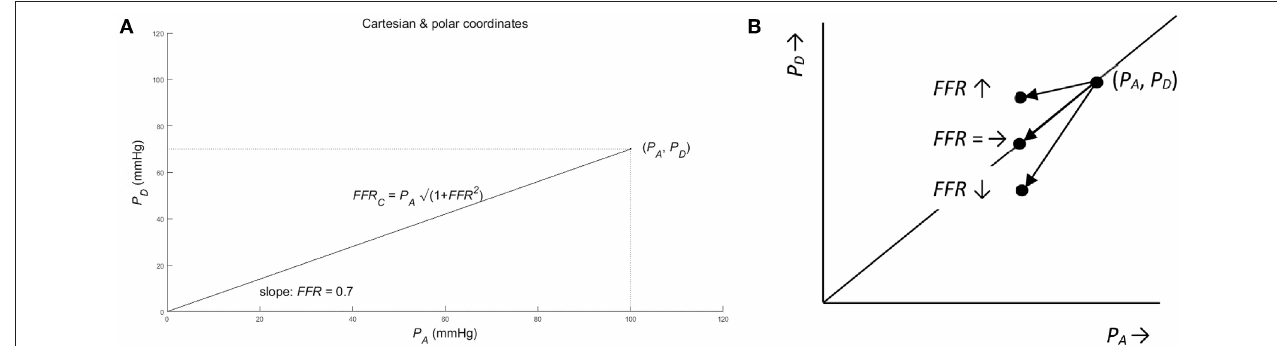
FIGURE 2 | (A) Cartesian and polar coordinates. The pressure P A and P D represented in Cartesian coordinates ( P A , P D ) (see dotted lines) and in polar coordinates FFR 2 , FFR ). Note that the pair of pressure ( P A , P D ) define exactly one point in the graph, while the single FFR defines a complete line in the graph. So, 1 ( P A + q(cid:0) (cid:1) mathematically speaking, the single FFR without the companion FFR C leaves ambiguity. As a result, all points on a line through the origin share the same value of FFR . (For details see Methods section). (B) Ambiguous change of FFR from point ( P A , P D ) for three different cases of a pressure decrease: The FFR is unchanged (see notation FFR ), if the change in P D is equal to the change of P A times FFR . Similarly, the FFR decreases (see FFR = smaller and larger than the change of P A times FFR , respectively (see section Methods for